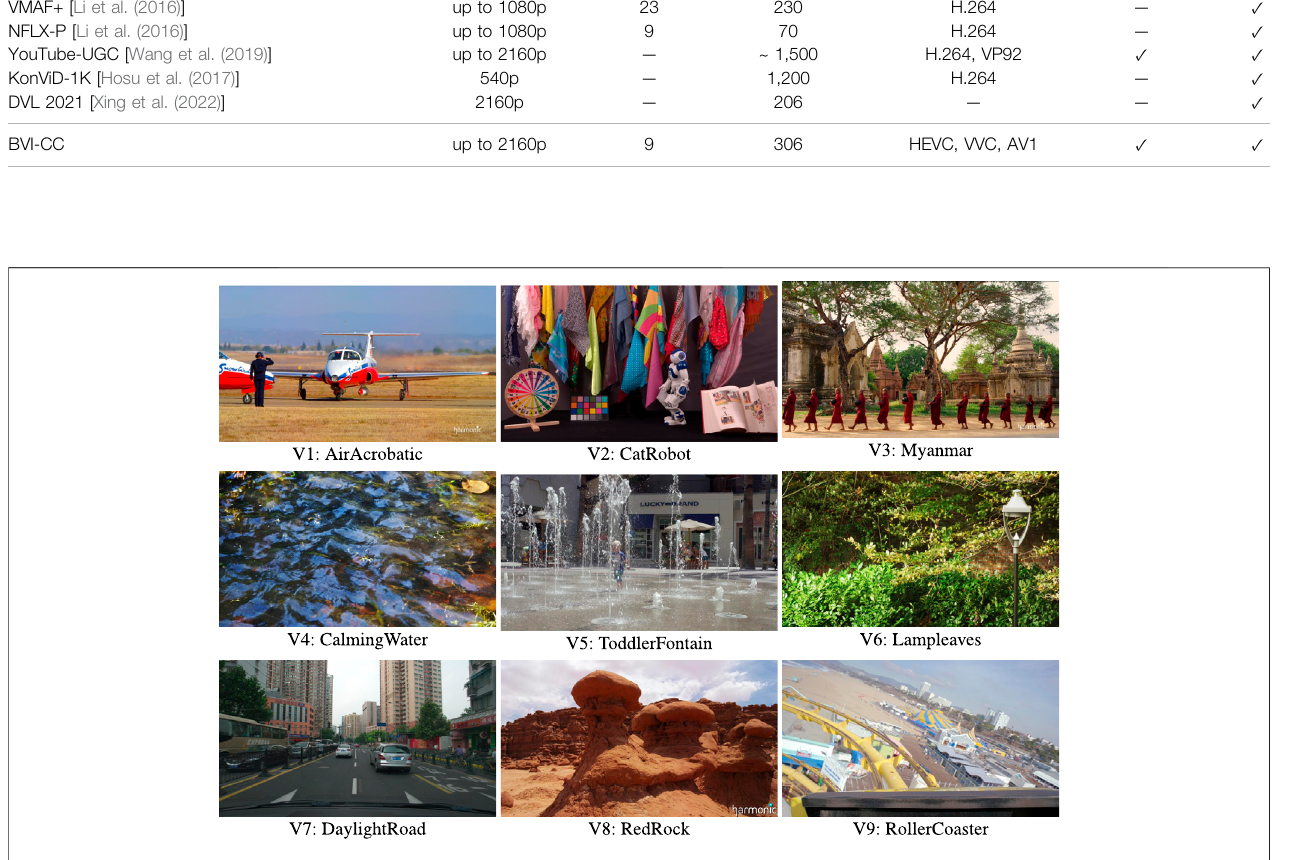
FIGURE 1 | Sample video frames from the selected source sequences.